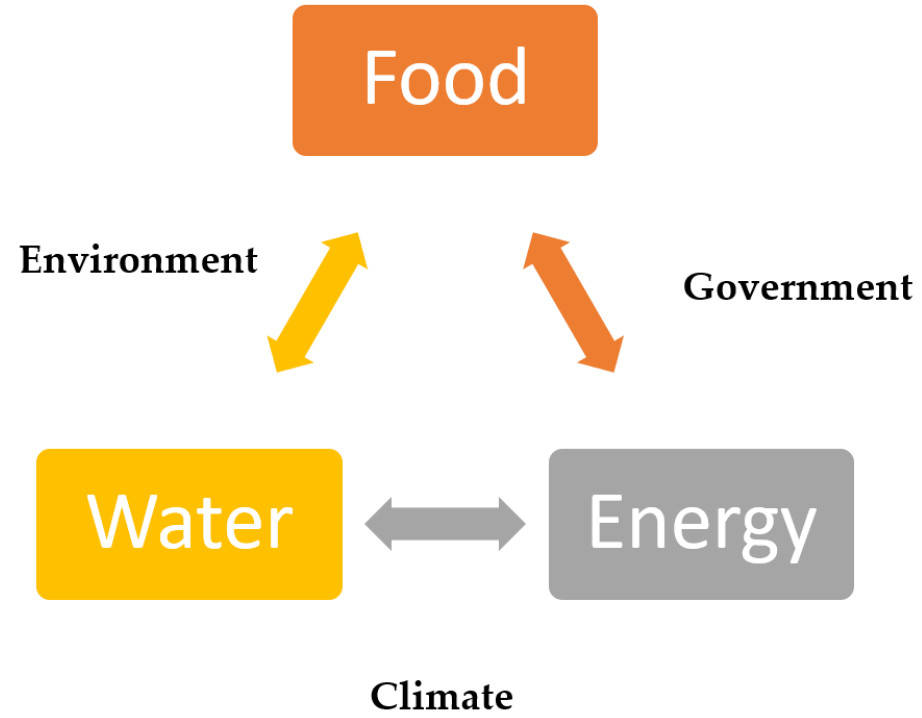
Figure 1. A conceptual model of the nexus redrawn from [5].